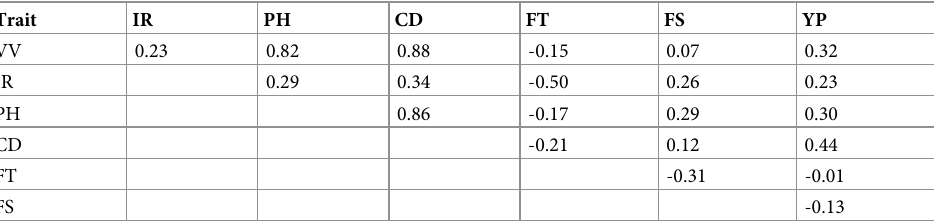
Table 9. Genotypic correlation among the following traits: Vegetative vigor (VV), incidence of rust (IR), plant height (PH), canopy diameter (CD), fruit ripening time (FT), fruit size (FS) and yield per plant (YP), evaluated in the hybrid coffee